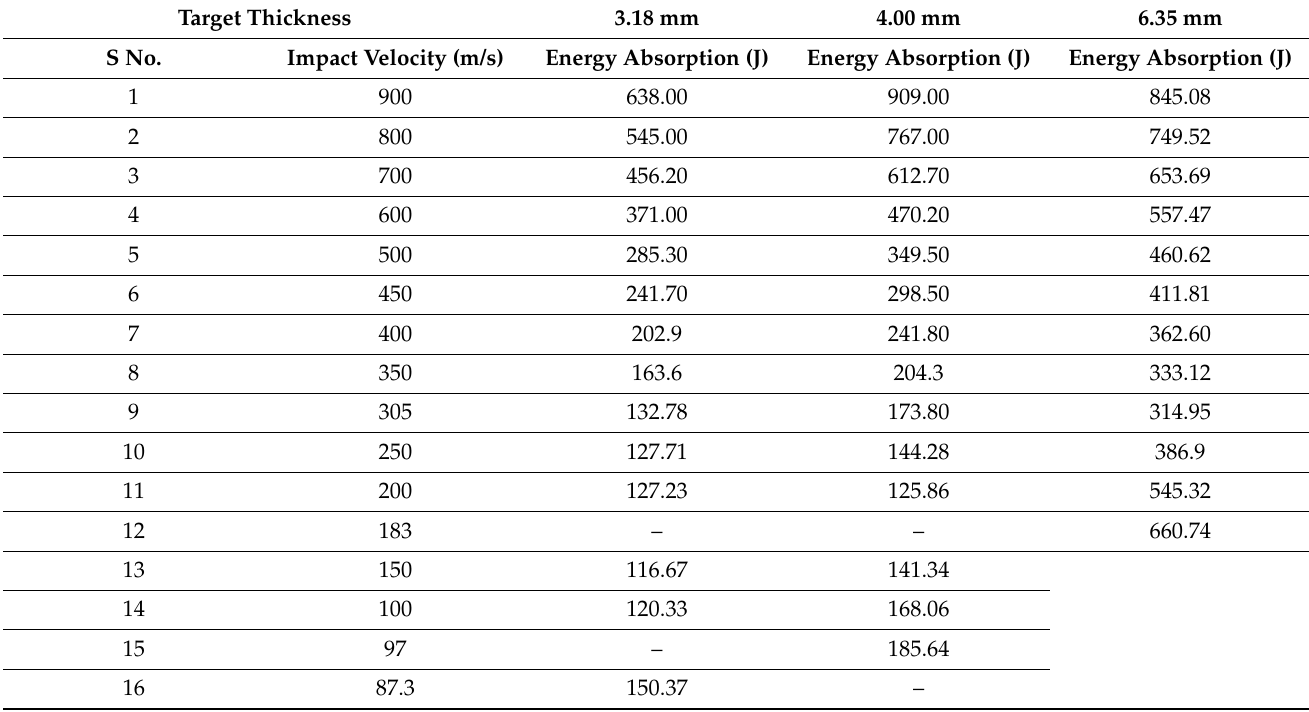
Table 7. Energy absorption of Al 2024-T3 alloy obtained from simulations for all thicknesses and for various impact velocities. Target Thickness